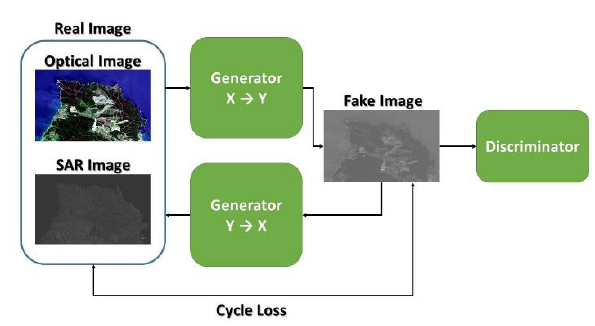
Figure 4. The basic structure of